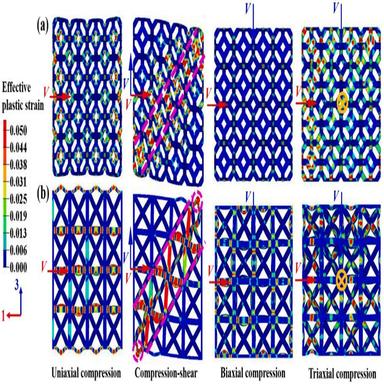
Deformable patterns of lattice structures under four typical loading scenarios when the nominal volumetric strain is 0.10: (a) KV lattices; and (b) SB lattices.